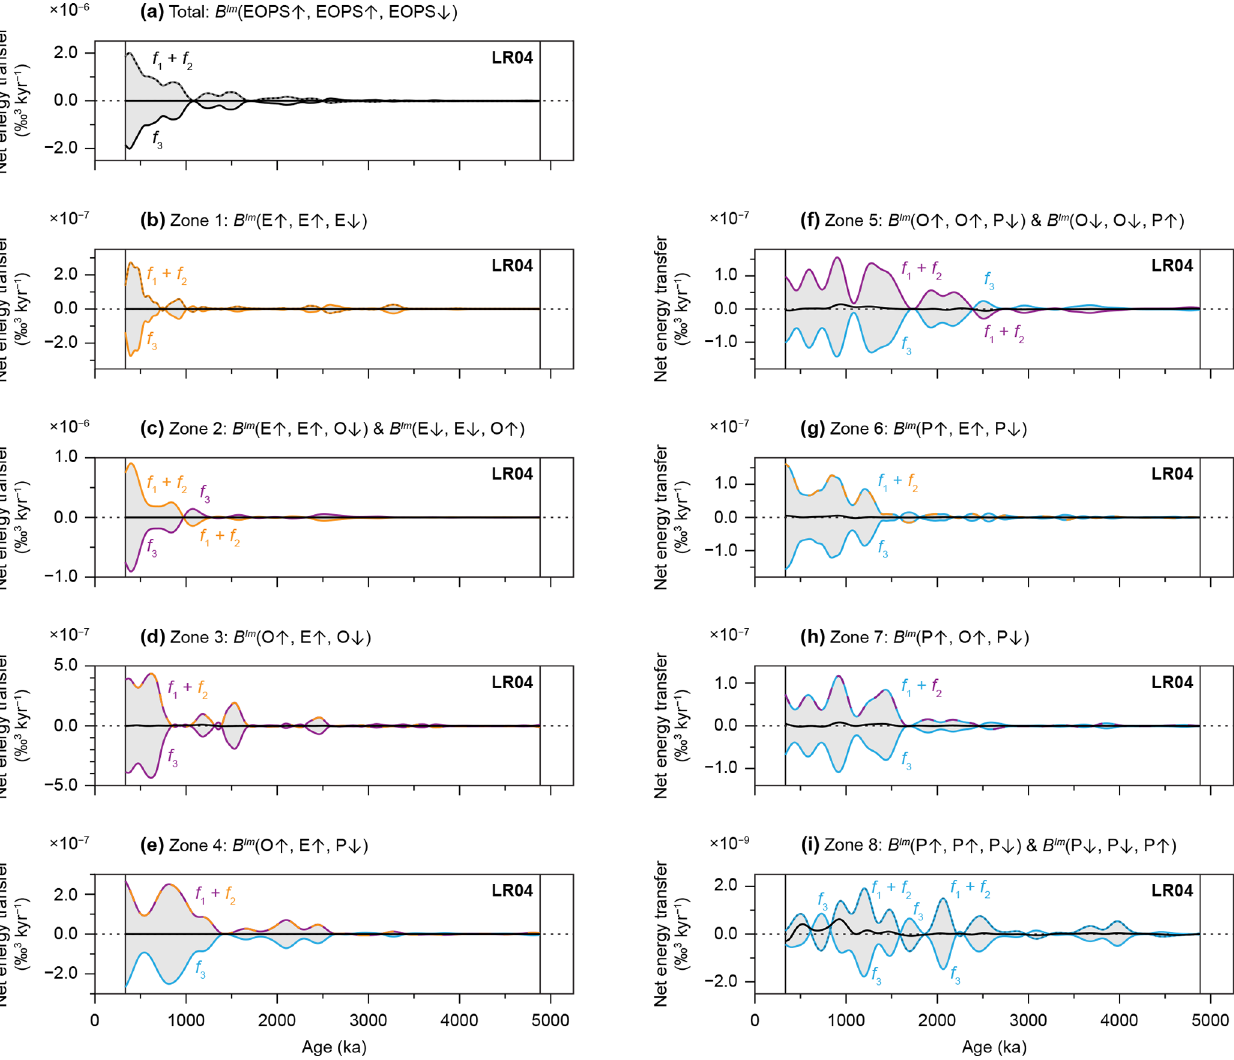
Figure 9. Conservation of energy in triad interactions located in the imaginary part of Pliocene and Pleistocene bispectra. Conservativity of (a) the entire bispectrum (Fig. 5b) and (b) Zone 1, (c) Zone 2, (d) Zone 3, (e) Zone 4, (f) Zone 5, (g) Zone 6, (h) Zone 7, and (i) Zone 8, of the bispectrum (Fig. 8). Energy gains or losses of f 1 and f 2 (dashed lines) are computed using Eq. (8), those of f 3 (single coloured lines) following Eq. (7), and their differences (black lines) by Eq.